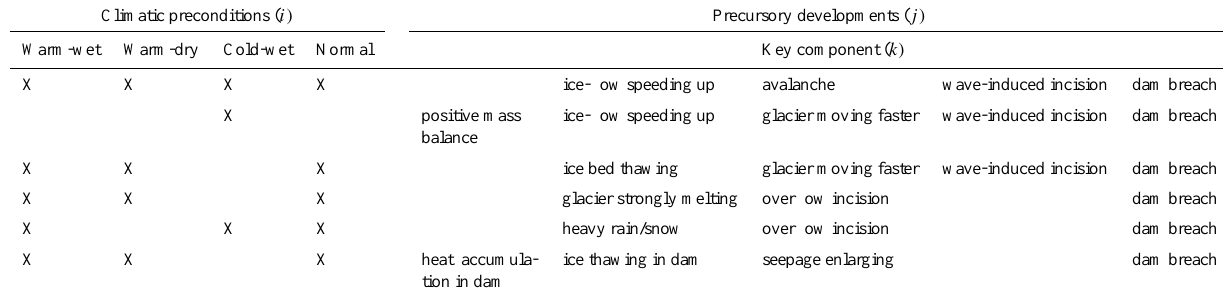
Table 4. Breaching mode and its chain components for a moraine-dammed lake under different climatic preconditions. Climatic preconditions ( i) Precursory developments ( j) Warm-wet Warm-dry Cold-wet